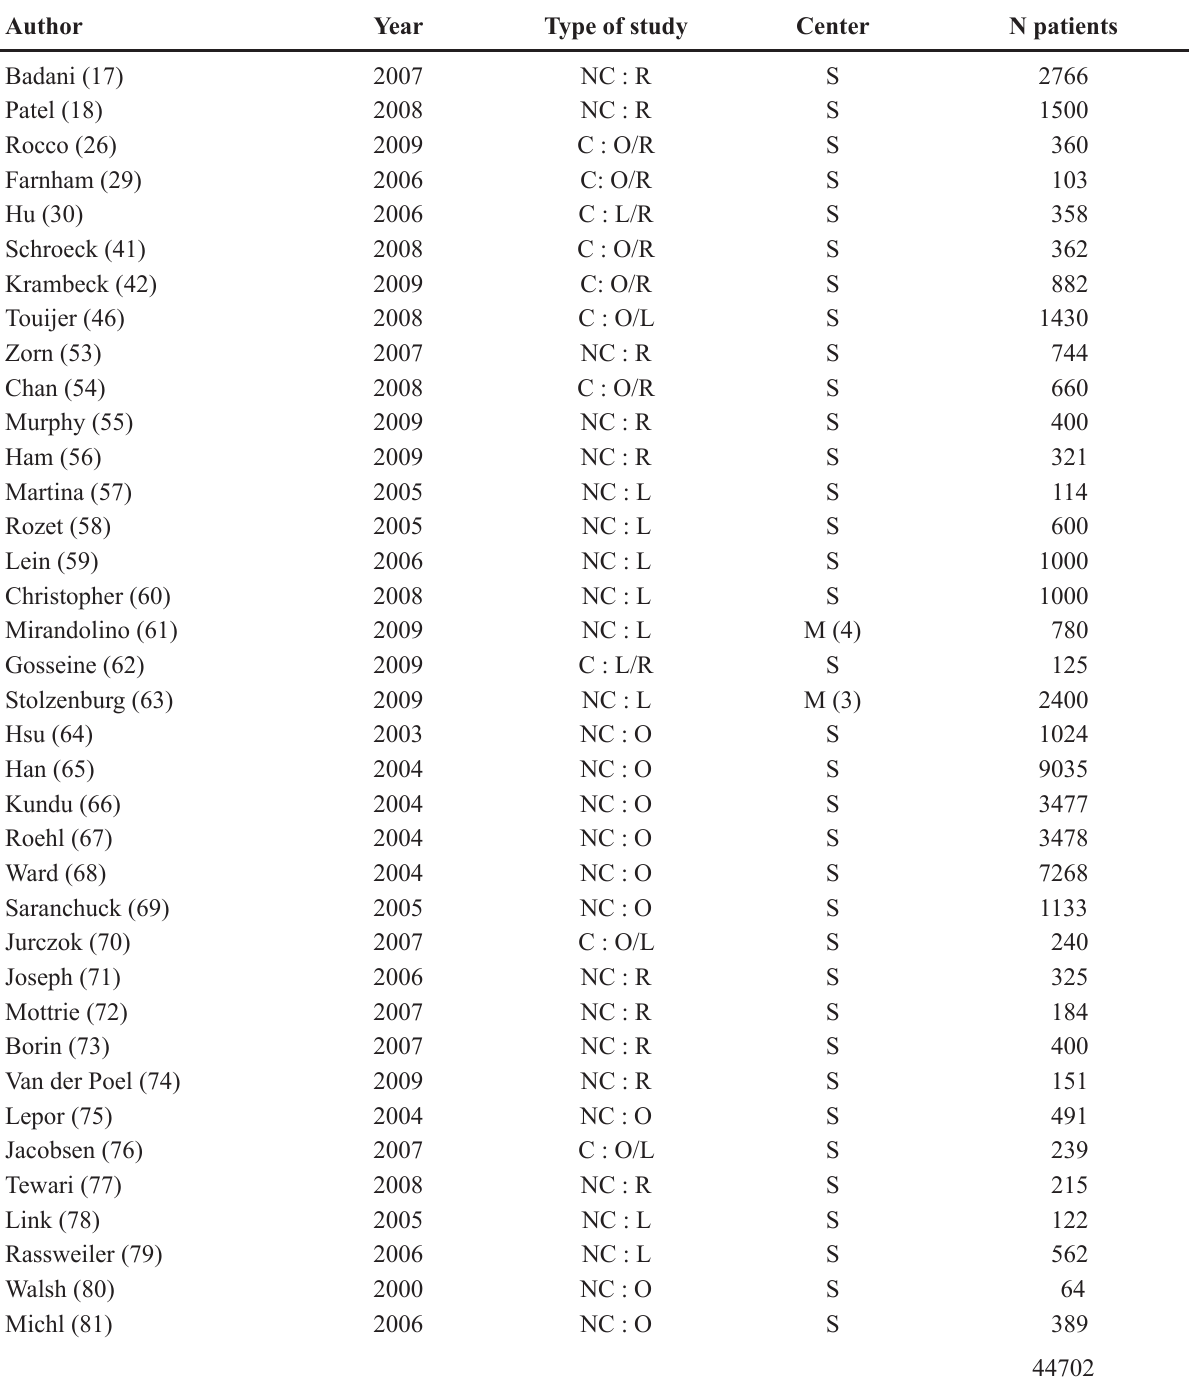
Table 1 – Studies included in the comparison between RRP, LRP and